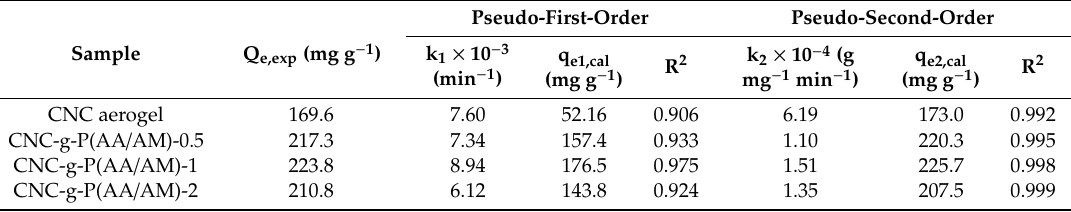
Table 1. Kinetic parameters for Pb(II) adsorption on the CNC-g-P(AA / AM)-0.5, CNC-g-P(AA / AM)-1, CNC-g-P(AA / AM)-2, and CNC aerogels.